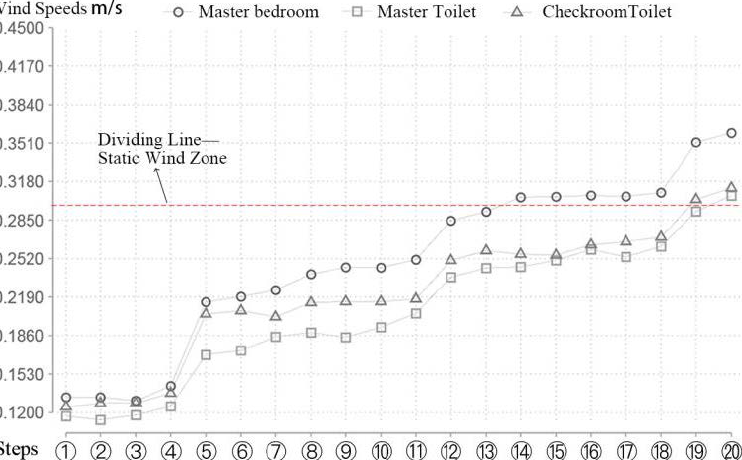
Figure 18. Comparison of average wind speed on the second floor at different optimization stages.